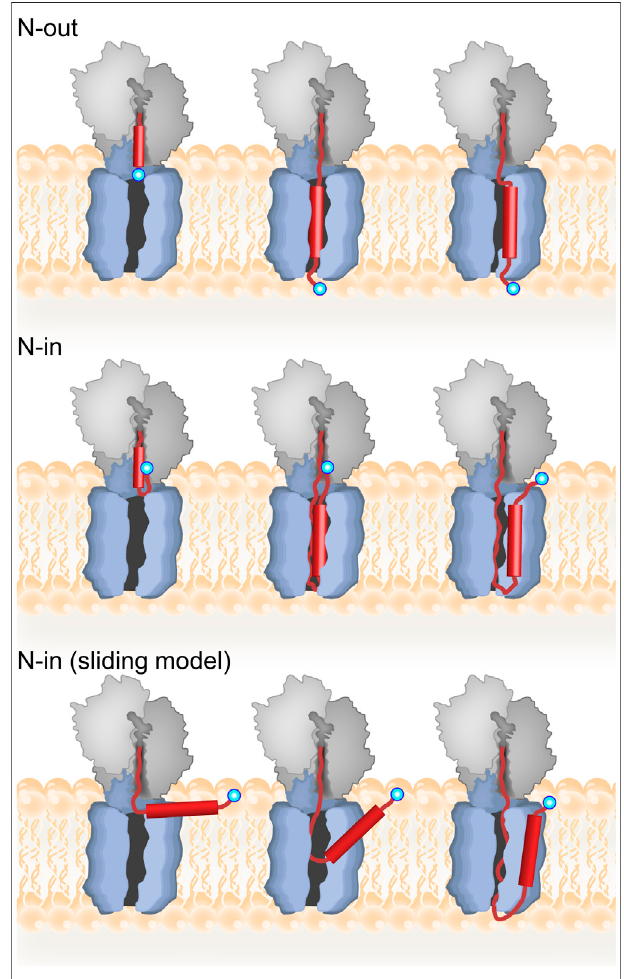
FIGURE3| Topologyofinner-membraneproteins. Toppanel: modelfor cotranslational N-out TM insertion where the TM inserts fi rst into the translocon prior to membrane integration. The nascent protein is depicted in red with the TM as a cylinder, and the N-terminus indicated by a blue circle.Middlepanel: modelforN-inTMinsertion withinversion occurring inthe ribosome prior to translocon insertion and then membrane integration. Bottom panel: alternative “ sliding model ” for N-in insertion where the TM does not insert into the translocon. For further discussion, see text.